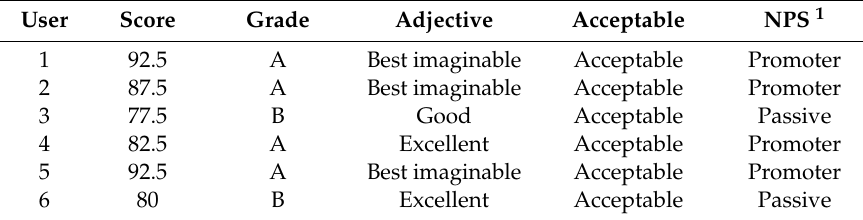
Table 4. System Usability Scale (SUS) scores for buyers. Self-source, 2020.